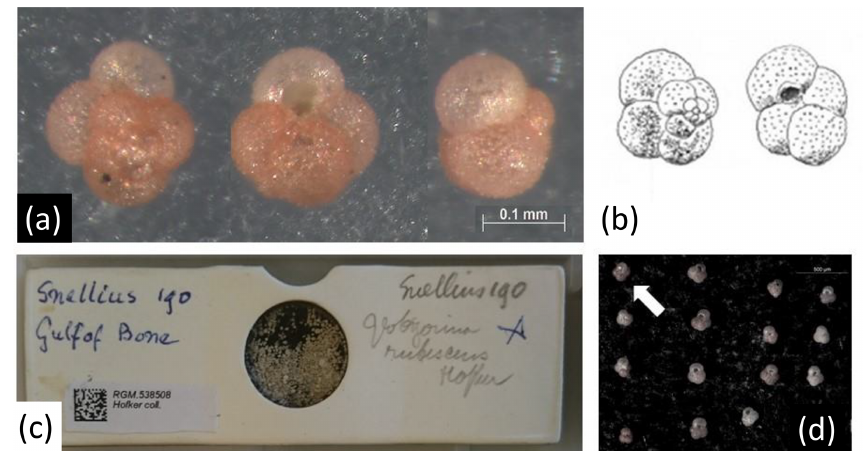
Figure 5. Lectotype (a) of Globoturborotalita rubescens (Hofker 1956) compared with original drawing (b) by Hofker (1956, his plate 35, figs. 18–19), selected from a slide marked originally by Hofker as containing “ Globigerina rubescens Hofker” and deposited at the Zoological Museum in Amsterdam, transferred in 2011 to the Naturalis Biodiversity Center, Leiden, the Netherlands, and registered as RGM 538508. The slide (c) contains a sieved residue from a sediment collected during the Snellius expedition (Snellius station 190) from the Gulf of Boni off Sulawesi, Indian Ocean, at 4 ◦ 43 (cid:48) S, 120 ◦ 22 (cid:48) E, 1407m water depth, taken on 15 February 1930 18.15–20.30 with an Ekman–Pratje sampler. The residue hosted 15 specimens of G. rubescens that were all extracted (d) , of which we here designate RGM 1333481 as the lectotype ( a ; white arrow in d ), and specimens RGM 1333482–1333495 as